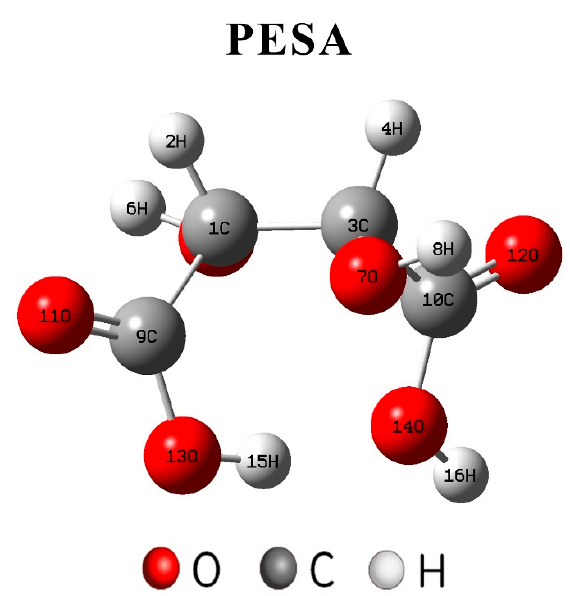
Figure 7. Optimal configurations of PAA.